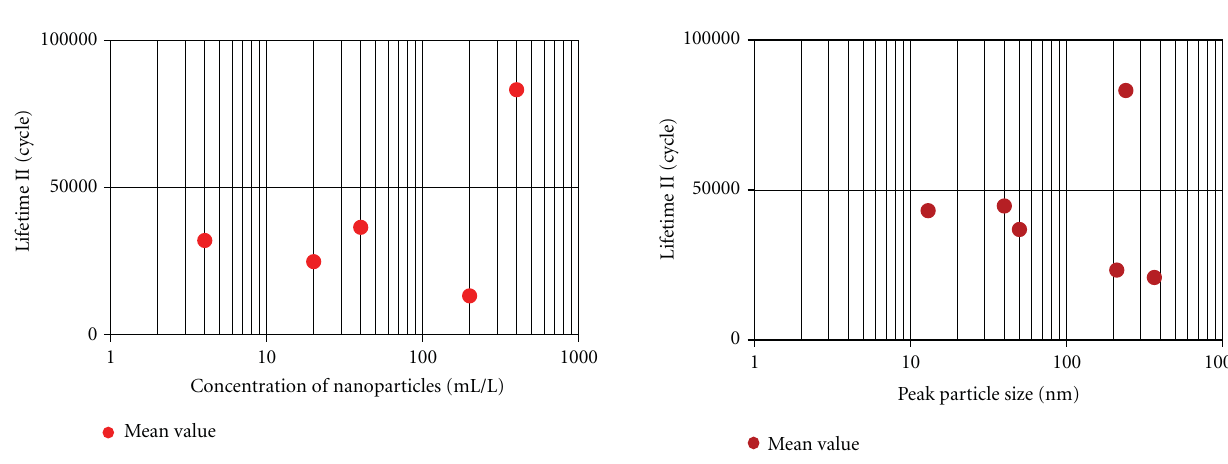
Figure 9: E ff ect of concentration of nanoscale particles in elec- trolyte (particles in liquid).